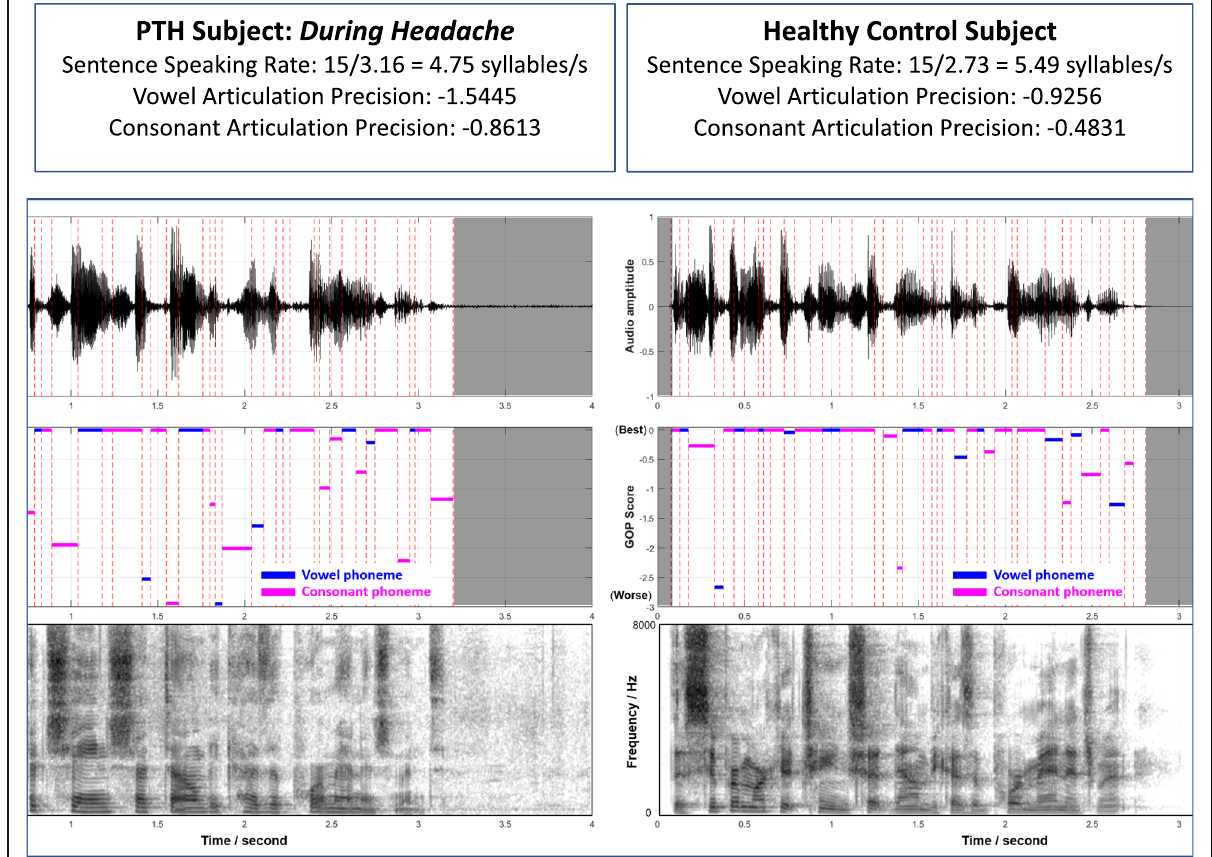
Fig. 3 Example of sentence speaking rate differences, and vowel and consonant articulation precision differences of an individual with PTH during headache (left) as compared to Healthy Control (right) for the sentence reading task “ The supermarket shut down because of poor management ” , which contains 15 syllables and 40